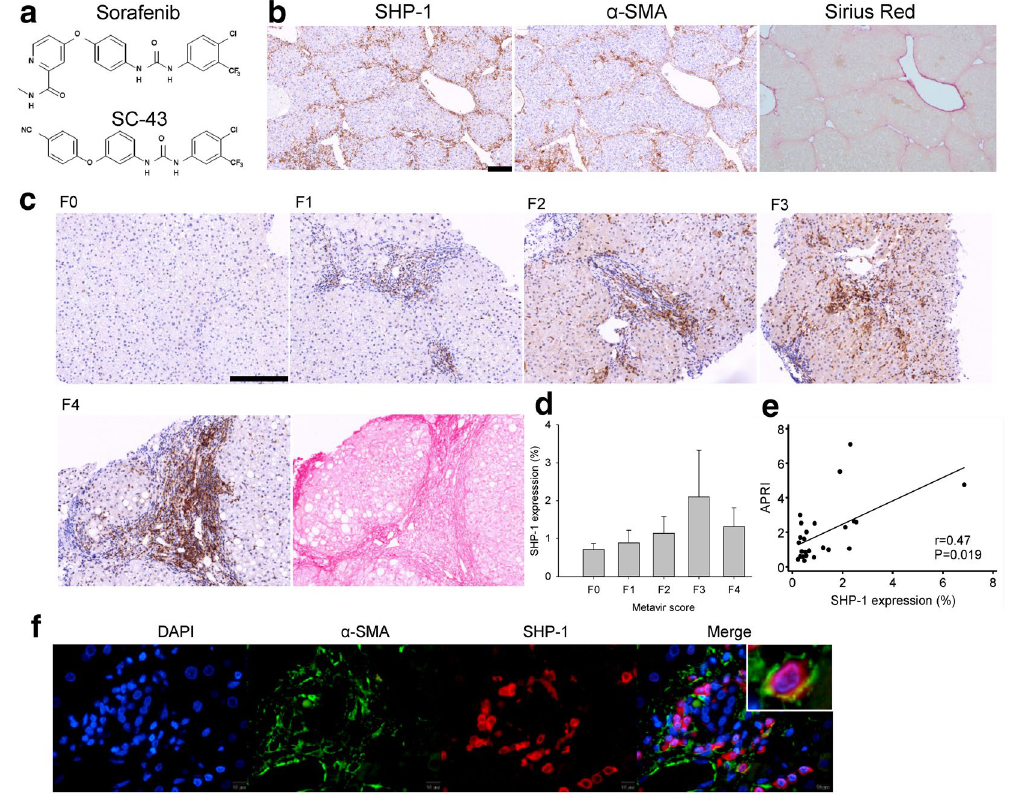
Figure 1. SHP-1 phosphatase is associated with liver fibrosis. ( a ) The structure of sorafenib and its derivative SC-43. ( b ) SHP-1 located primarily in areas with α -SMA-expressed activated HSCs and significant fibrosis by sirius red staining of the CCl 4 -induced fibrosis mouse liver. ( c ) SHP-1 overexpression in fibrotic areas of patients with CHB with advanced fibrosis, graded by the Metavir scores (F0–F4). The SHP-1 located in sirius red-positive fibrotic areas. ( d ) SHP-1 expression according to Metavir score. ( e ) SHP-1 expression positively correlated with APRI. ( f ) SHP-1 colocalized with α -SMA-expressed activated HSCs in human liver. Scale bar: 200 μ